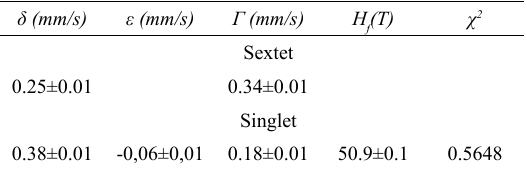
Figure 9. Mössbauer spectrum for the LaBiFe applied fitting model. Table 2. Hyperfine parameters of LaBiFe of room temperature Mössbauer